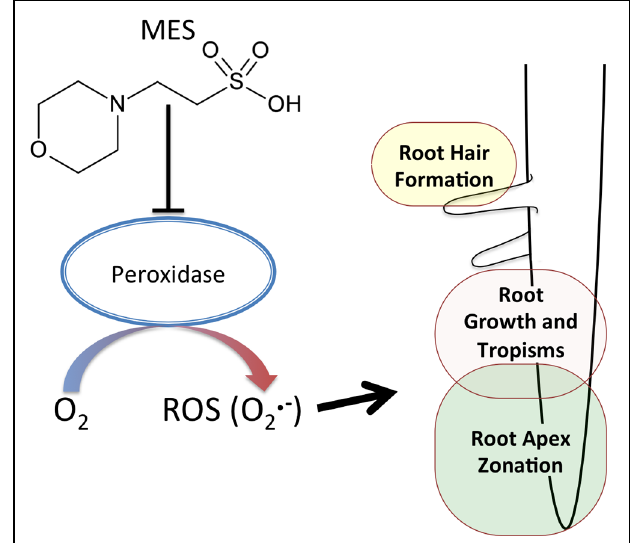
FIGURE 4 | A schematic diagram of MES effects on root growth. MES disturbs ROS-generating pathway in the root apex, possibly via enzymes (e.g., peroxidases), affecting the root apex zonation. The ROS (O 2 •− ) is involved in root hair formation, root growth and root